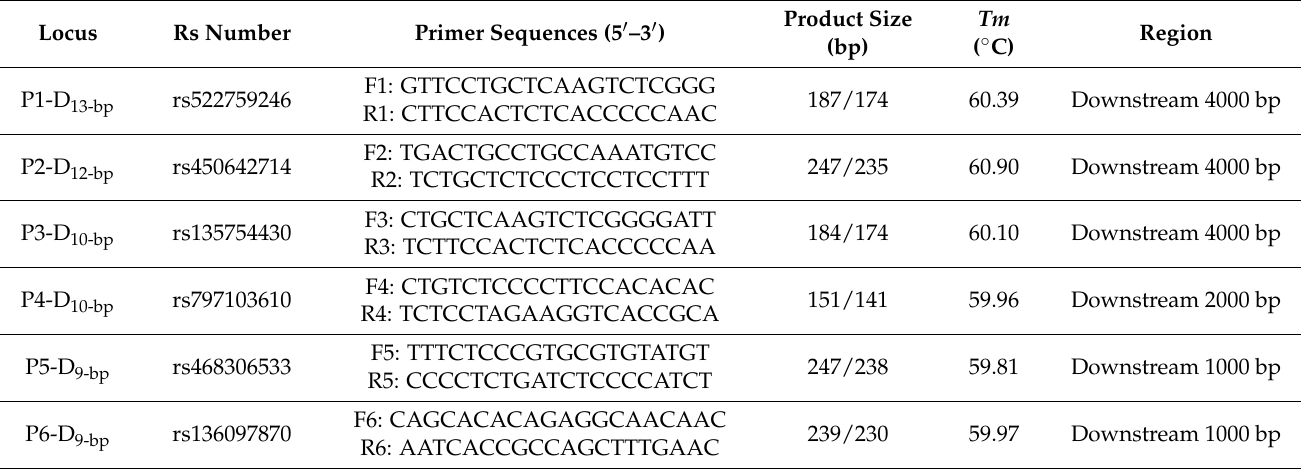
Table 1. PCR primer sequences for ITG β 5